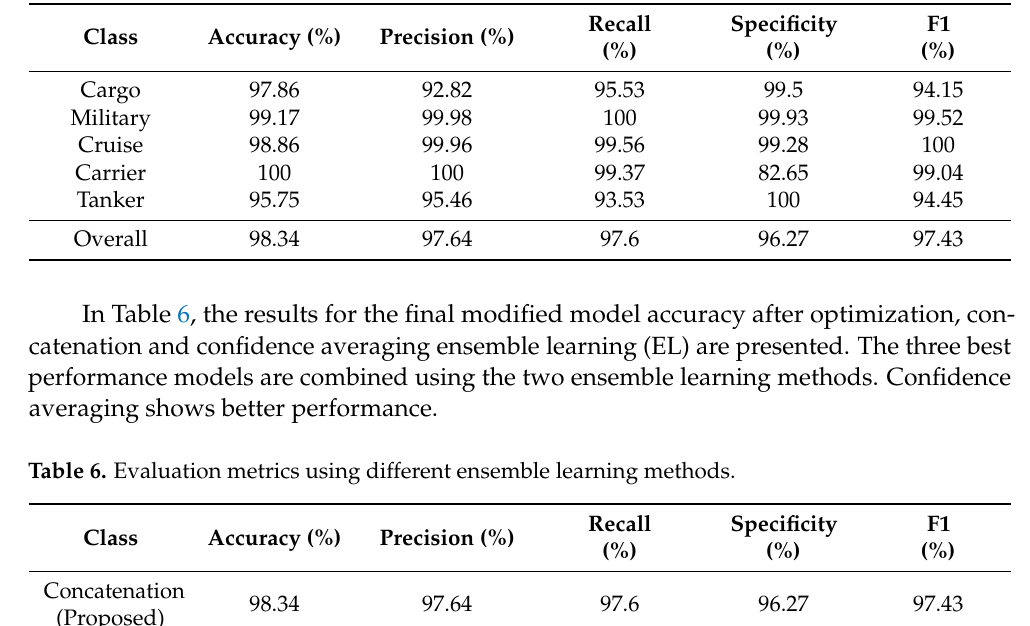
Table 5. Evaluation metrics for the Game of Deep Learning Ship dataset.